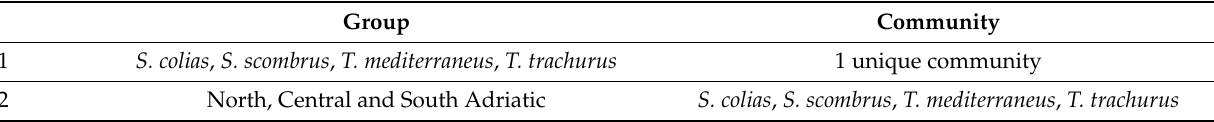
Table 1. Groups and communities considered to run SIBER on SIA results. Group